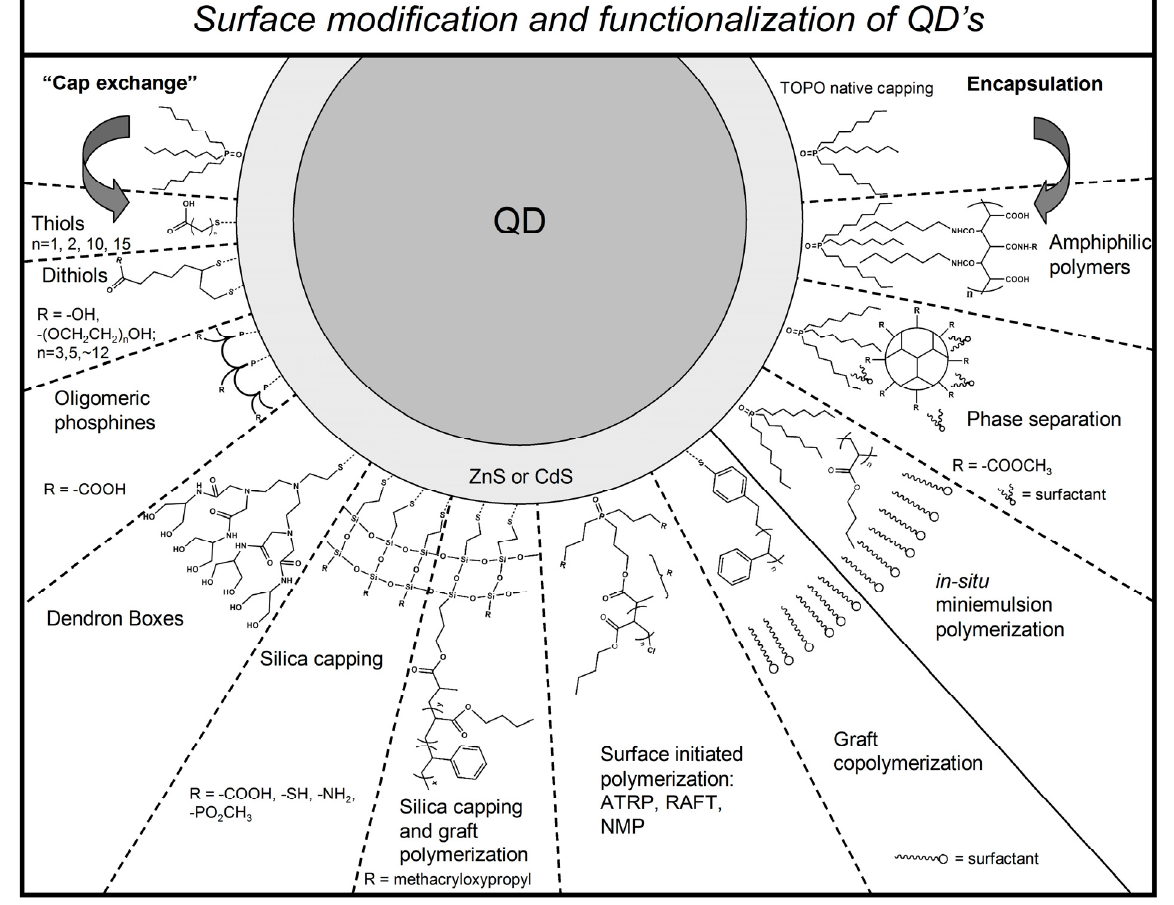
Figure 3. Scheme illustrating some of the methods for chemical surface modification of